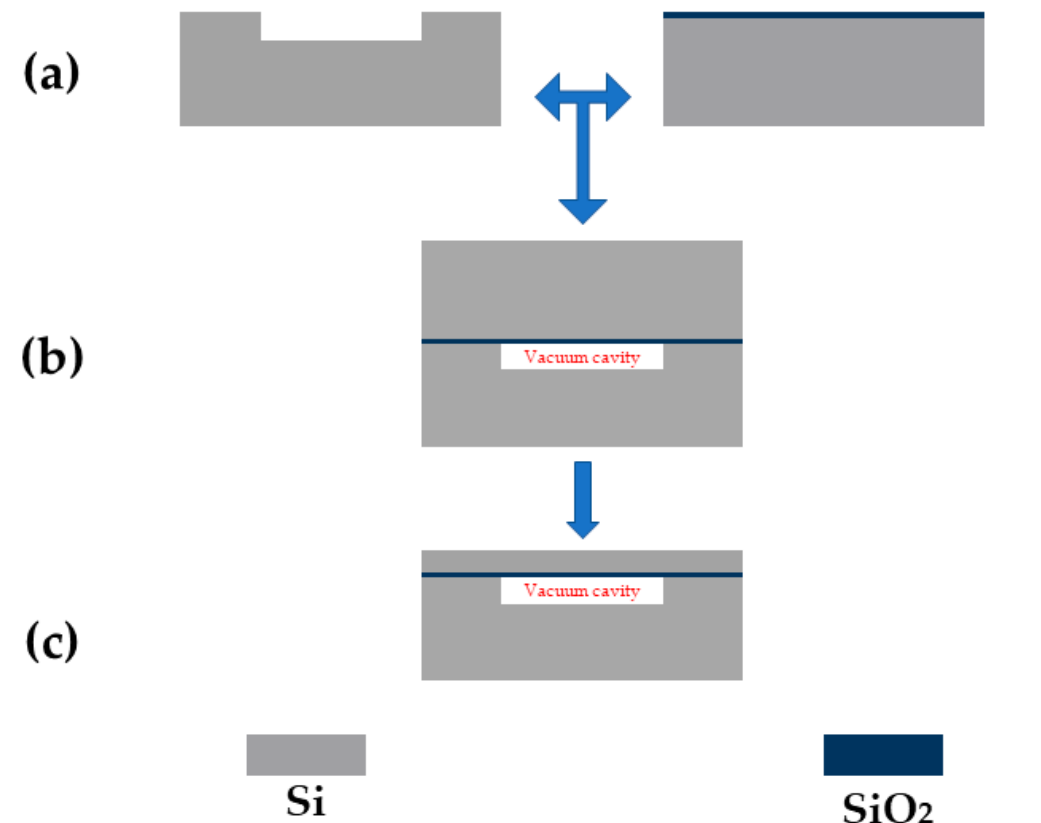
Figure 8. Fabrication process flow of the CSOI: ( a ) a 20 µ m deep cavity are patterned and etched by deep reactive ion etch (DRIE) in the base silicon wafer, in the meantime, the device silicon wafer was thermal oxidized to form a 1 µ m oxide layer on the surface as a temperature compensation layer, ( b ) the handle wafer and the device wafer were bonding together using hydrophilic bonding technology, ( c ) thinning the device wafer down to 6 µ m which contains 1 µ m SiO2 layer and 5 µ m silicon layer.